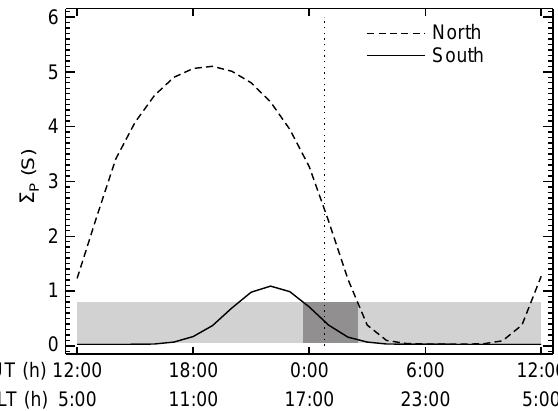
Fig. 4. Pedersen conductance after the IRI90 at the footpoints in the ionospheres in the Northern ( dashed line ) and Southern ( solid line ) Hemisphere. The time interval is May 2, 1985, 12:00 UT – May 3, 1985, 12:00 UT. The dotted line indicates the time of the observed frequency step. The light grey shaded region shows the range of typical values of the magnetospheric wave conductance. The dark grey shaded region indicates the occurrence of di(cid:128)erent signs in the reflection coe(cid:129)cient at